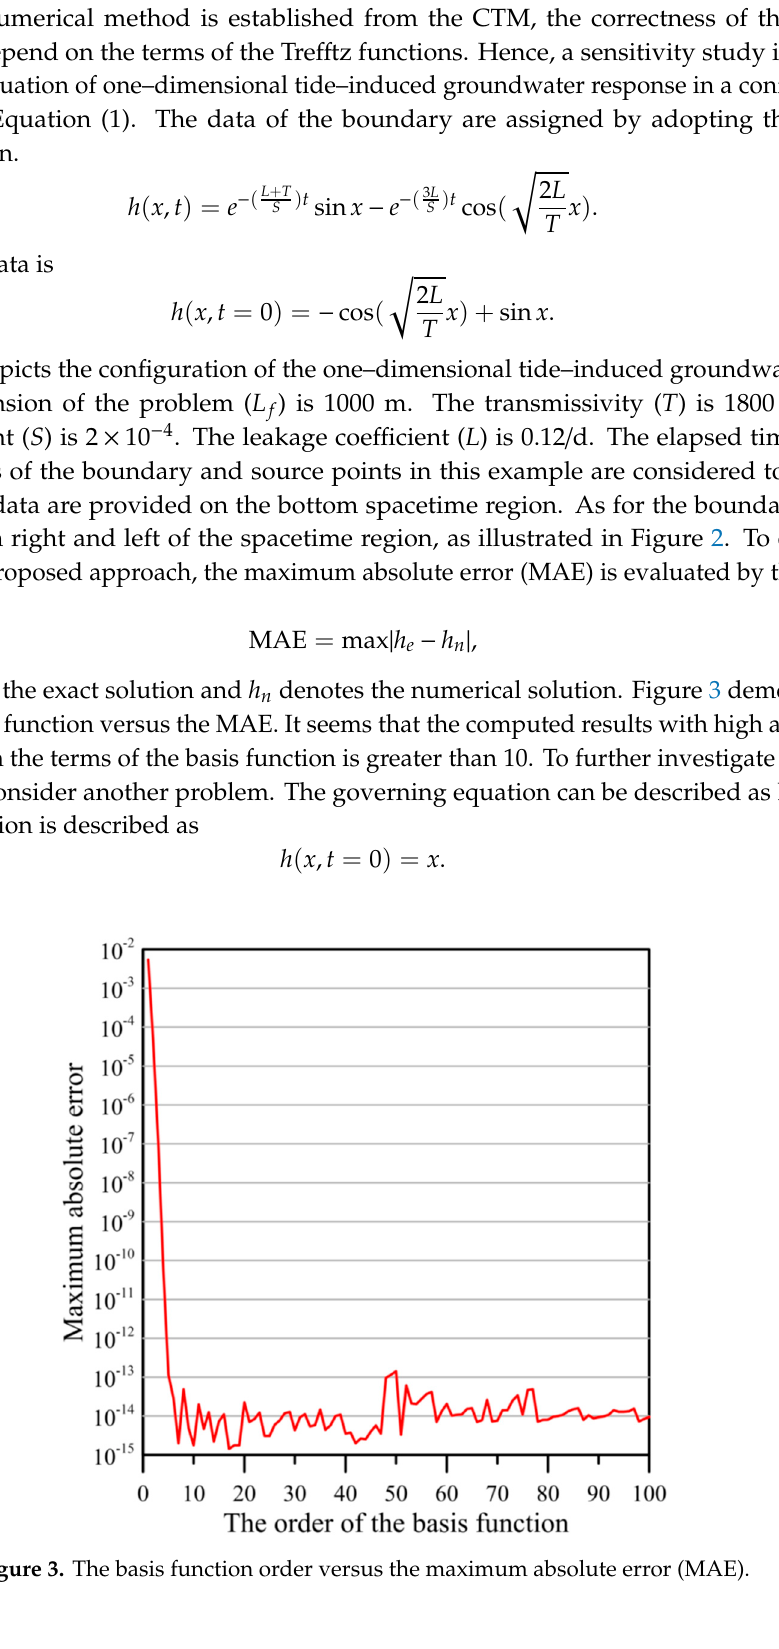
Figure 4. Result comparison of example 1.